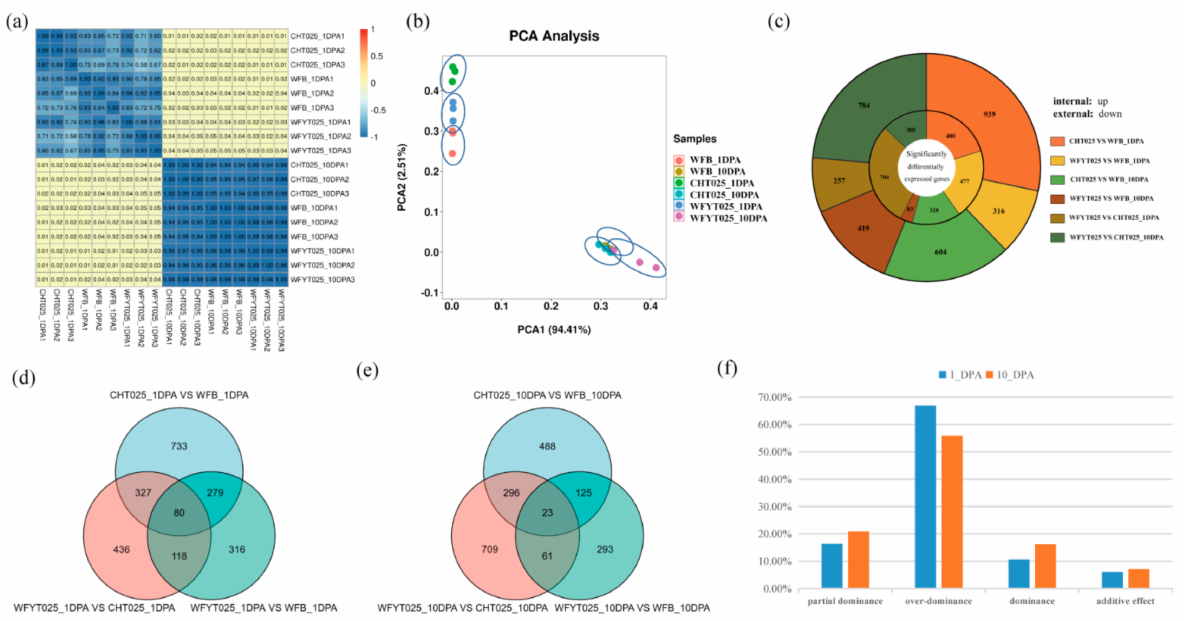
Figure 3. Transcriptome reveals DEGs for grain weight heterosis of the WFYT025 combination. ( a ) The correlation coefficient between the three biological replicates of the WFYT025 combination sample at the gene expression level. ( b ) Principal component analysis of the transcriptomes of samples from six stages. ( c ) Differentially expressed genes in six comparison groups. ( d ) Venn diagram of DEGs between the hybrid and its parents on 1 DPA. ( e ) Venn diagram of DEGs between the hybrid and its parents on 10 DPA. ( f ) Breakdown of the DGHP according to the dominance ratio Hp. Depending on the principal of Hp = [d]/[a], Hp was classified as either positive or negative.